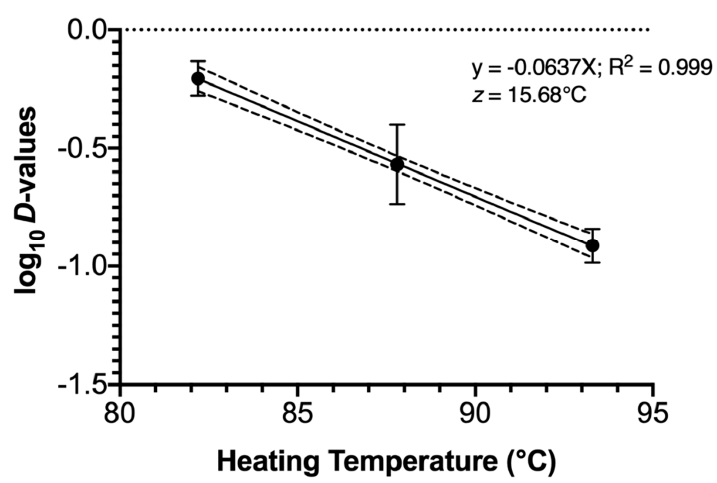
Figure 4. Thermal process constant ( z -value) for Salmonella enterica inoculated and heated in whole chicken blood. Symbols depict mean calculated from three identically completed replicates ( N = 3); error bars depict one standard error. Dashed lines present the 95% confidence limit boundaries.